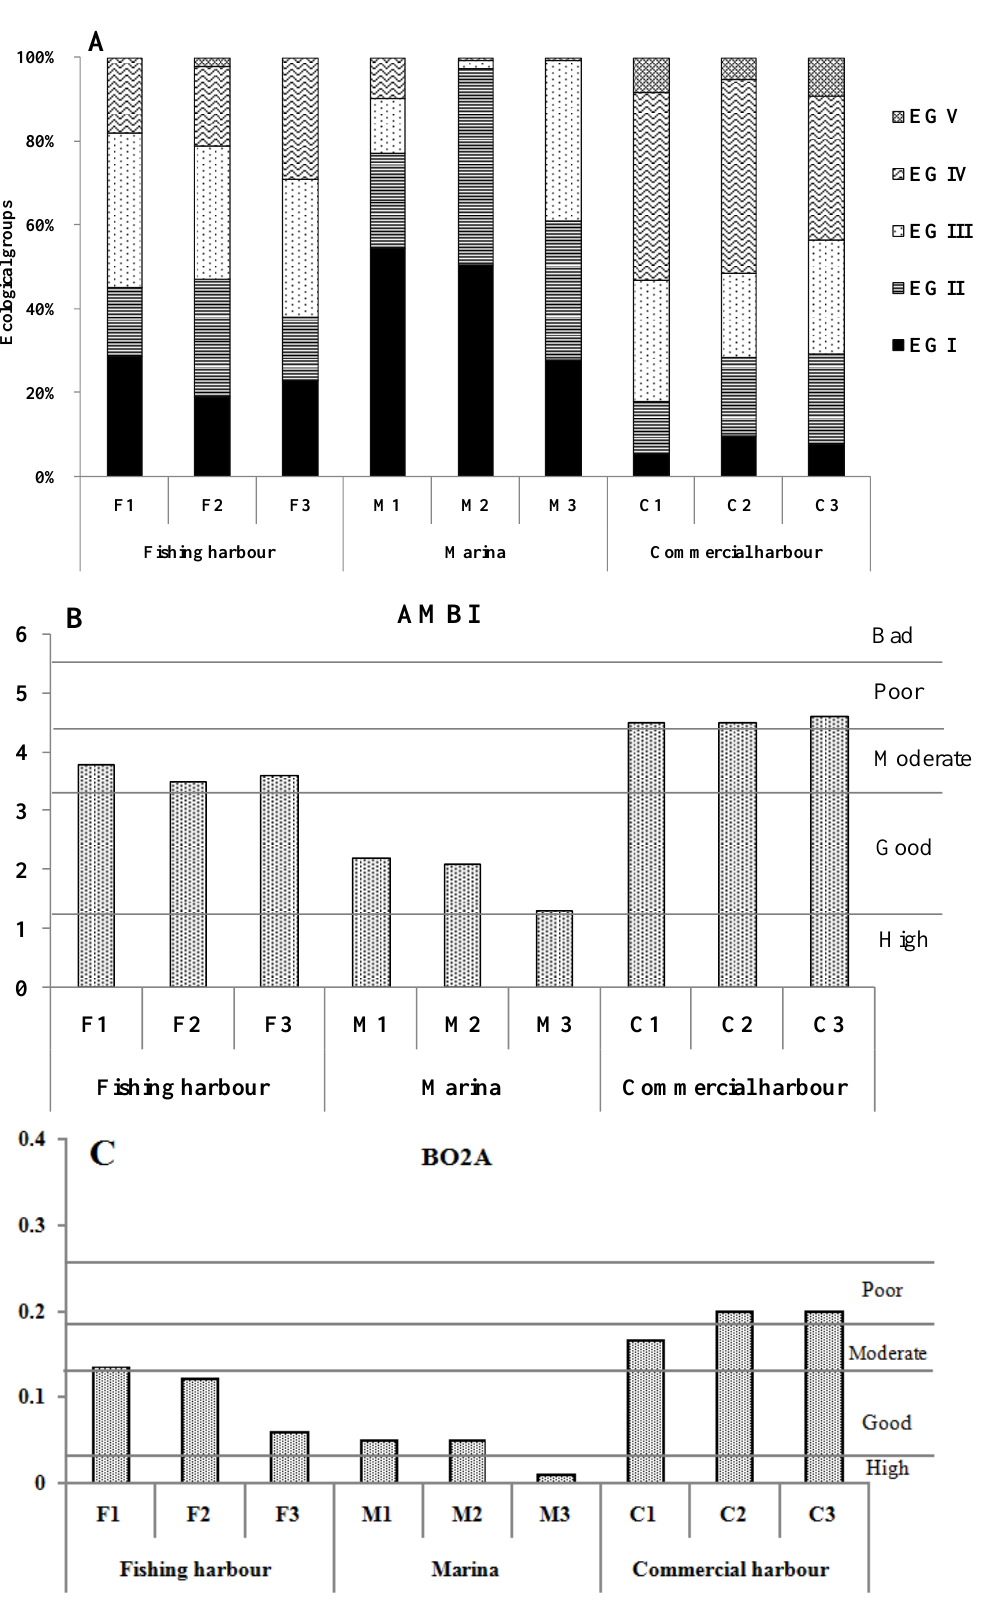
Figure 7. Spatial variability of the ecological groups ( A ) and biotic indices ( B , C ) in the harbours. EGI: sensitive species, EGII: species indifferent to organic matter enrichment, EGIII: species tolerant to excess organic matter enrichment, EGIV: second-order opportunistic species, EGV: first-order opportunistic species. Biotic indices show a significant difference between the three different harbours (ANOVA; F = 2.4; p < 0.05 (for AMBI) and F = 1.2; p < 0.05 (for BO2A)) (Figure 7). Biotic indices suggest that the Monastir marina has a higher environmental quality compared with the fishing harbour of Teboulba and the commercial harbour of Sousse, both of which show very low diversity (number of taxa and abundance) and moderate ecological status as assessed by H ′ , J ′ , and the three biotic indices used here. The benthic diversity (number of species and abundance) and the biotic indices (H ′ , J ′ , AMBI, and BO2A) show a signifi- cant correlation with some environmental factors such as type of sediment, organic mat- ter, and heavy metal contamination, mainly Cd, Hg, Fe, and Pb (Appendix C). 4. Discussion Study of the impacts of anthropogenic perturbations and heavy metal pollution on harbour ecosystems is an important step in establishing appropriate environmental man- agement and protection of marine biodiversity [40]. When the concentration of heavy met- als in the coastal ecosystem reaches a certain level, it presents high impact to the structure, diversity, and abundance of the macrobenthic communities and the function of harbour ecosystems [9,21]. This paper illustrates the ecological risk assessment of heavy metals and environmental quality of central Tunisian harbours, central Mediterranean Sea. 4.1. General Patterns of the Benthos of the Three Harbours In the present study, 94 taxa of benthic invertebrates are identified belonging to six zoological groups, including five nonindigenous species. In terms of number of species and abundance, the three harbours have higher percentages of molluscs and annelids, but the commercial harbour is dominated by polychaetes, whereas the marina and fishing harbour are dominated by molluscs followed by crustaceans. A predominance of poly- chaetes is usually observed in other harbour ecosystems (i.e., Gulf of Gabès harbours in Tunisia, Algerian harbours, Valdez harbour in Alaska, Mumbai harbour in India, and